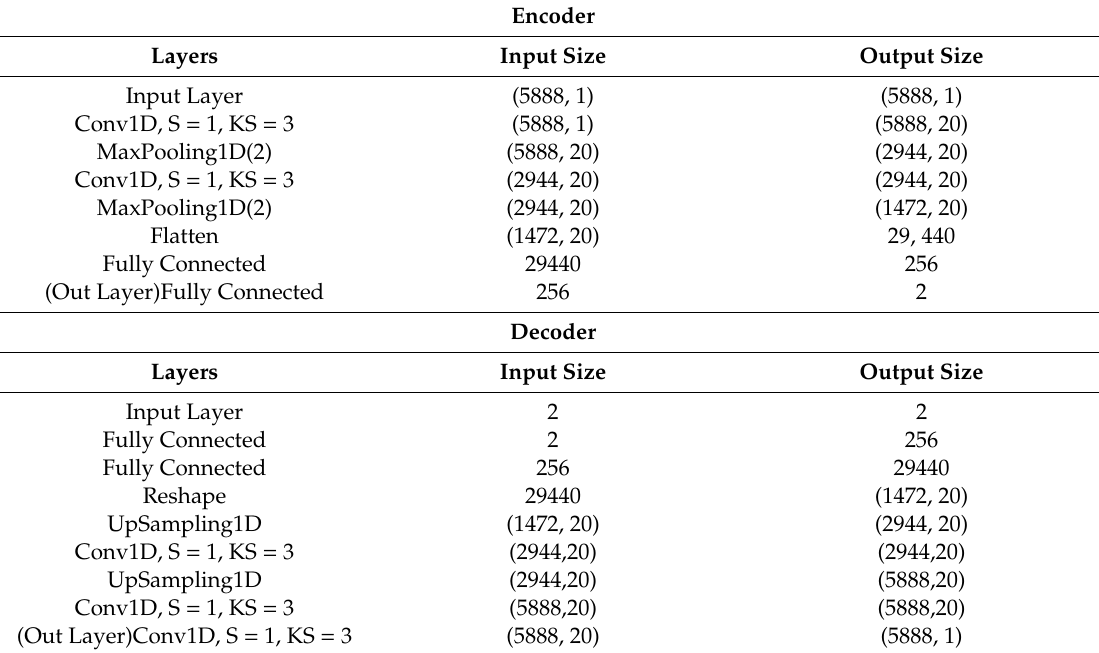
Table 3. The structures of encoder and decoder